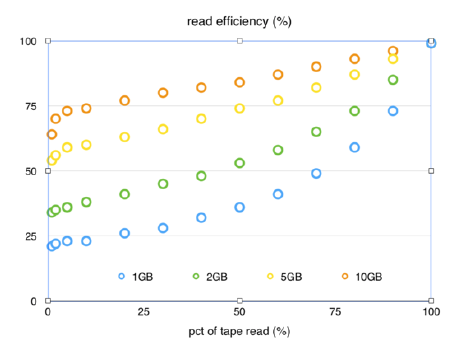
Fig. 3 : Simulation of tape read efficiency (courtesy of Luc Goossens from